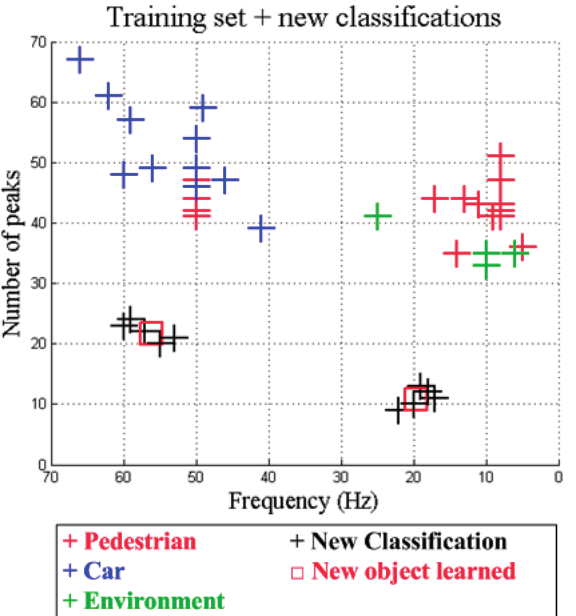
Figure 15. Training set including new classifications.